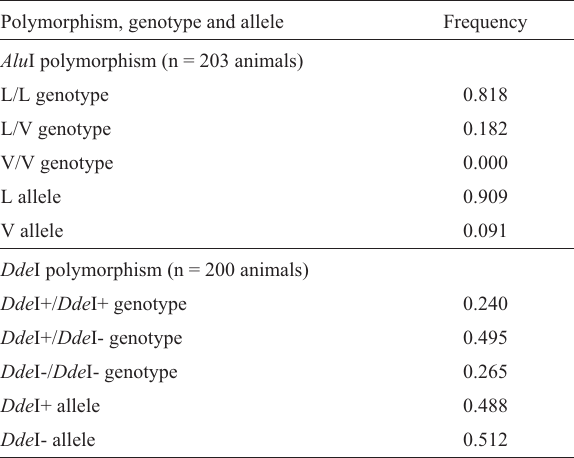
Table 2 - Genotype and allele frequencies of the Alu I and Dde I poly- morphisms in exon 5 of the growth hormone 1 gene ( GH1 ) of Canchim calves.